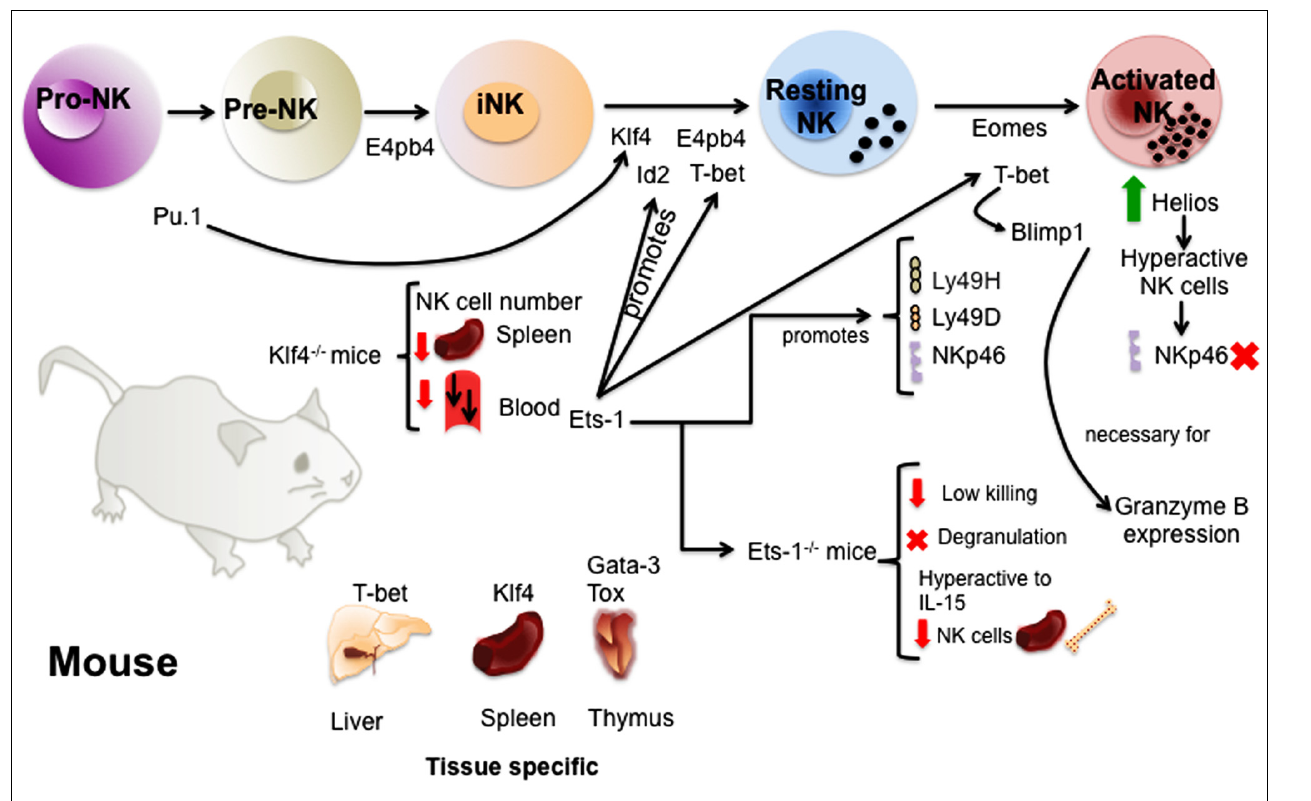
from immature to mature NK cells. A complex network ofTFs act downstream or upstream of theseTFs and others regulating the acquisition of receptors and NK cell function. Finally, some of theTFs like Gata-3, Klf4,T-bet, andTox have been shown to be important for the regulation of tissue-specific NK